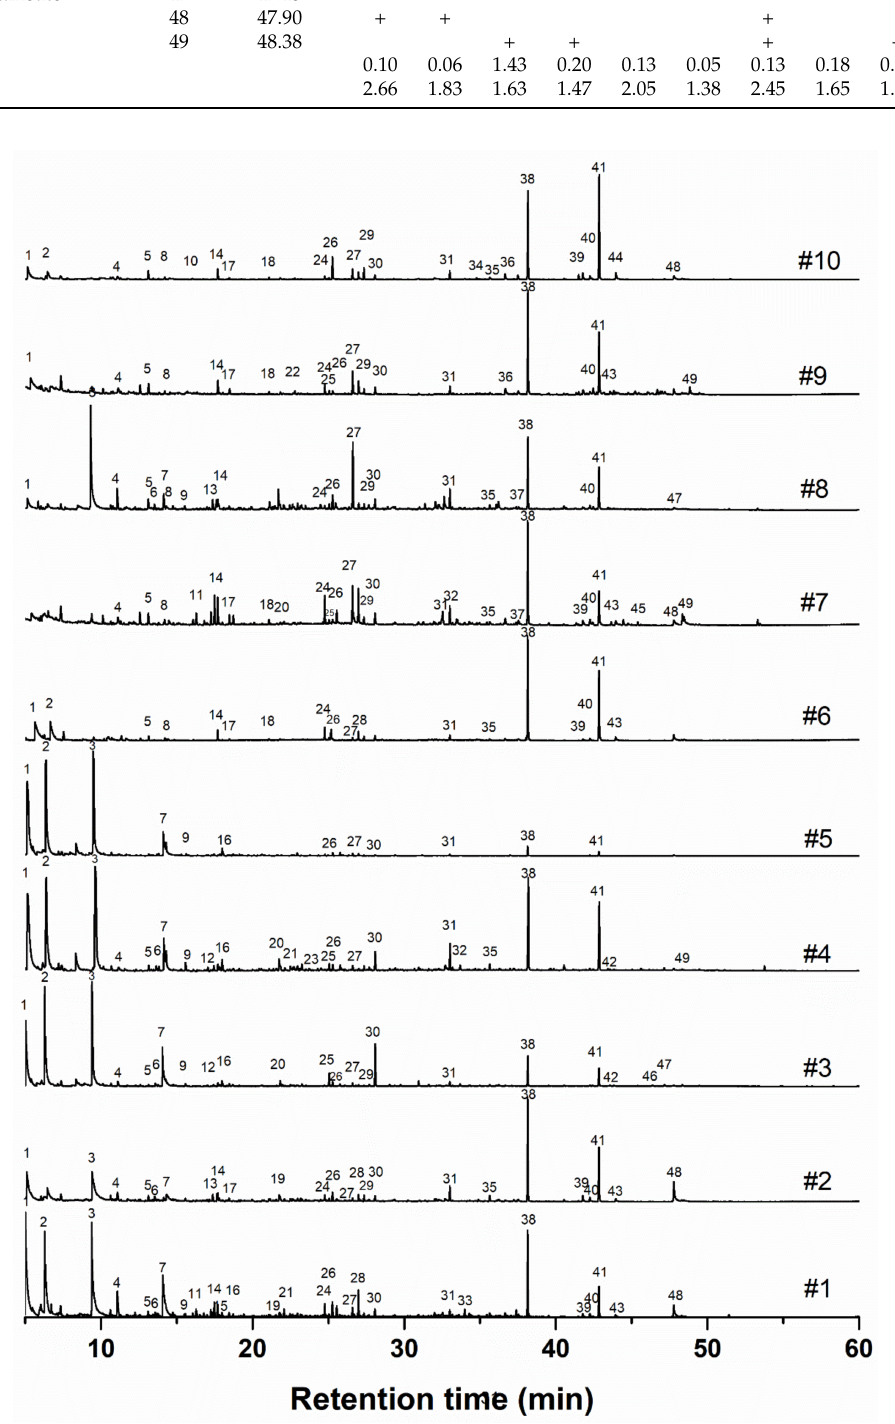
Figure 4. Py-GC/MS total ion chromatogram (TIC) of the gilding samples. With the exception of sample #5, strong dry oil aging products such as C18, C16, and 2C 9 were detected, indicating that dry oils were used in these samples. Among the identified pyrolysis products, palmitic acid (C 16:0 , No. 38) and stearic acid (C 18:0 , No.